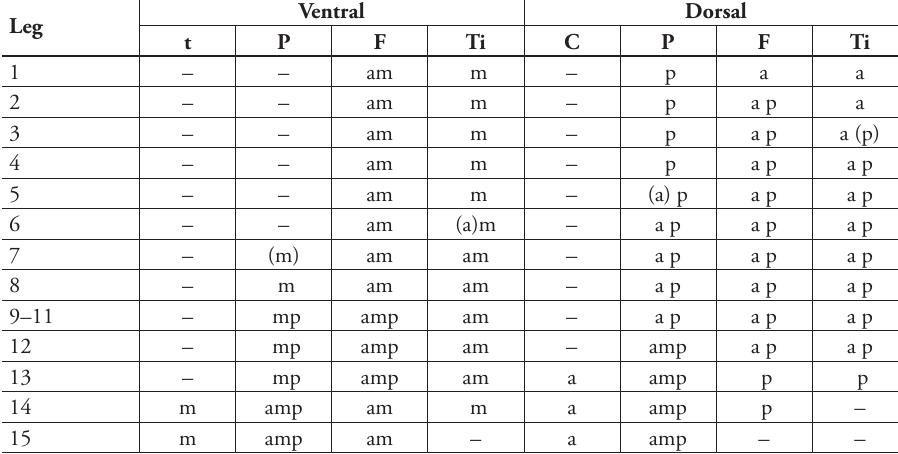
Table 1. Plectrotaxy of L. yuchernovi sp. n. Holotype. Brackets show the presence of an asymmetric spine in one of leg